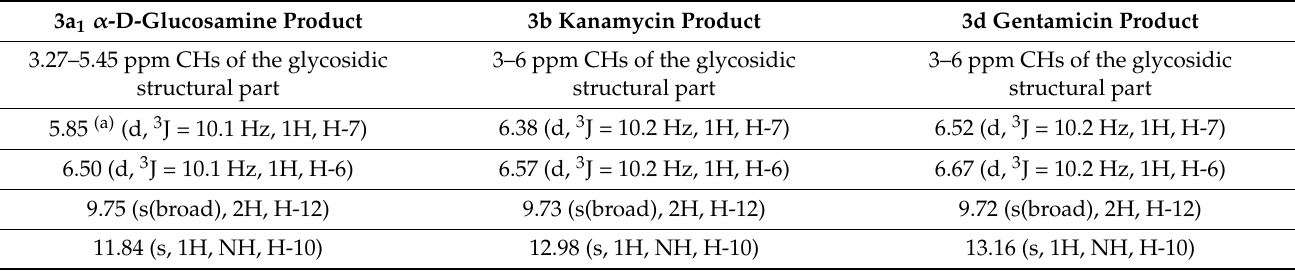
Table 3. 1 H assignments for 3b and 3d in comparison to 3a 1 .